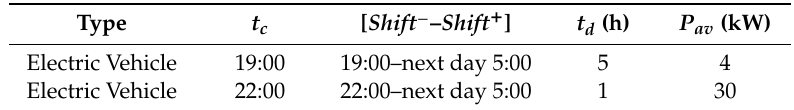
Table 2. The Parameters of Shiftable Loads.